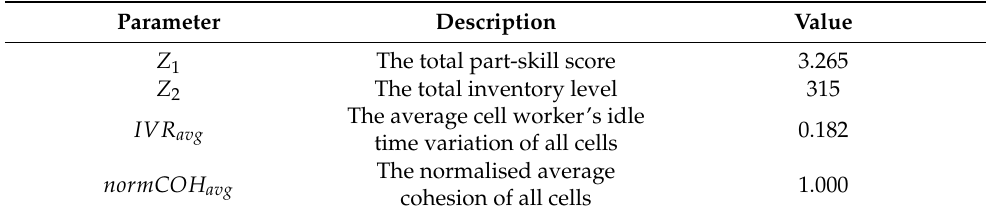
Table 12. Solution obtained by using two-stage ALNS for the illustrative